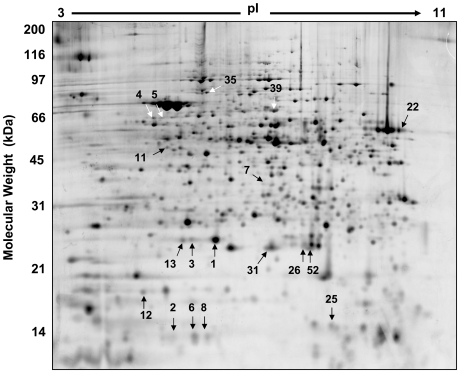
Regulated proteins of the S. solfataricus proteome after exposure to 30 µM H2O2.Approximately 818 spots (common to all gels) were used in the CyDye 2D DIGE analysis. 18 protein spots changed significantly in abundance 105 minutes post H2O2. Spots that changed in abundance are indicated with arrows. Protein identifications were made using in-gel proteolysis followed by LC-MS/MS and are listed in Table 2.